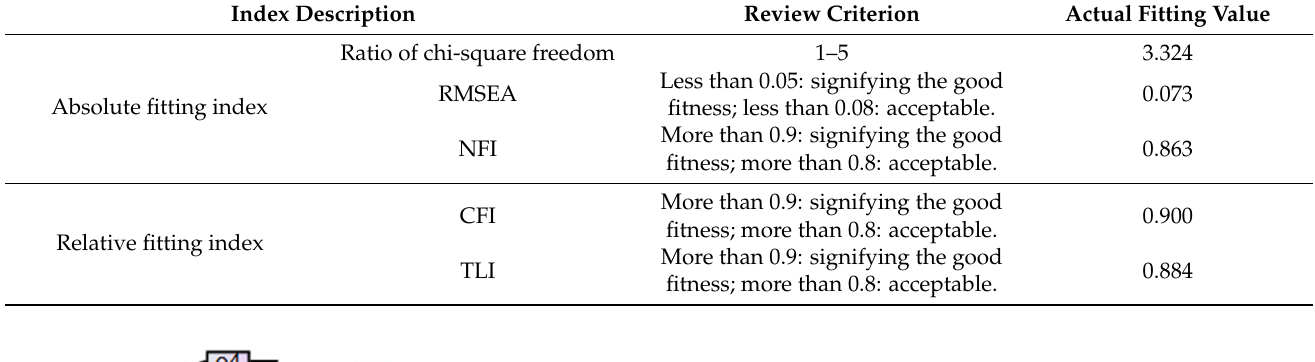
Table 11. Fitted value for corrected data.